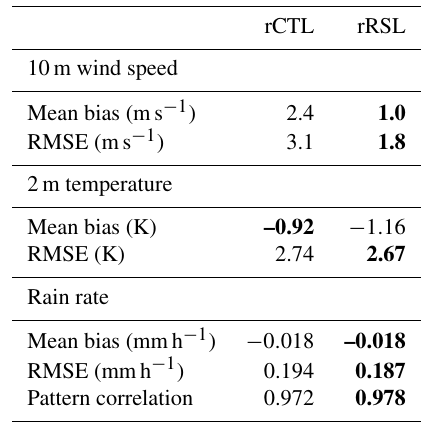
Table 2. Statistics of the 10m wind speed, 2m temperature, and rain rate. The top statistics are presented in